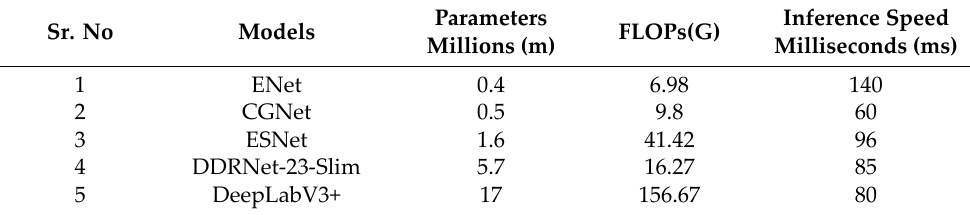
Table 2. Computational cost comparison of all trained